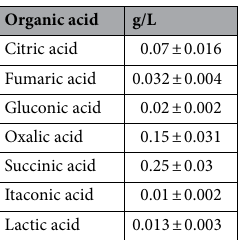
Table 2. Organic acid production profile determined in C. eragrostidis